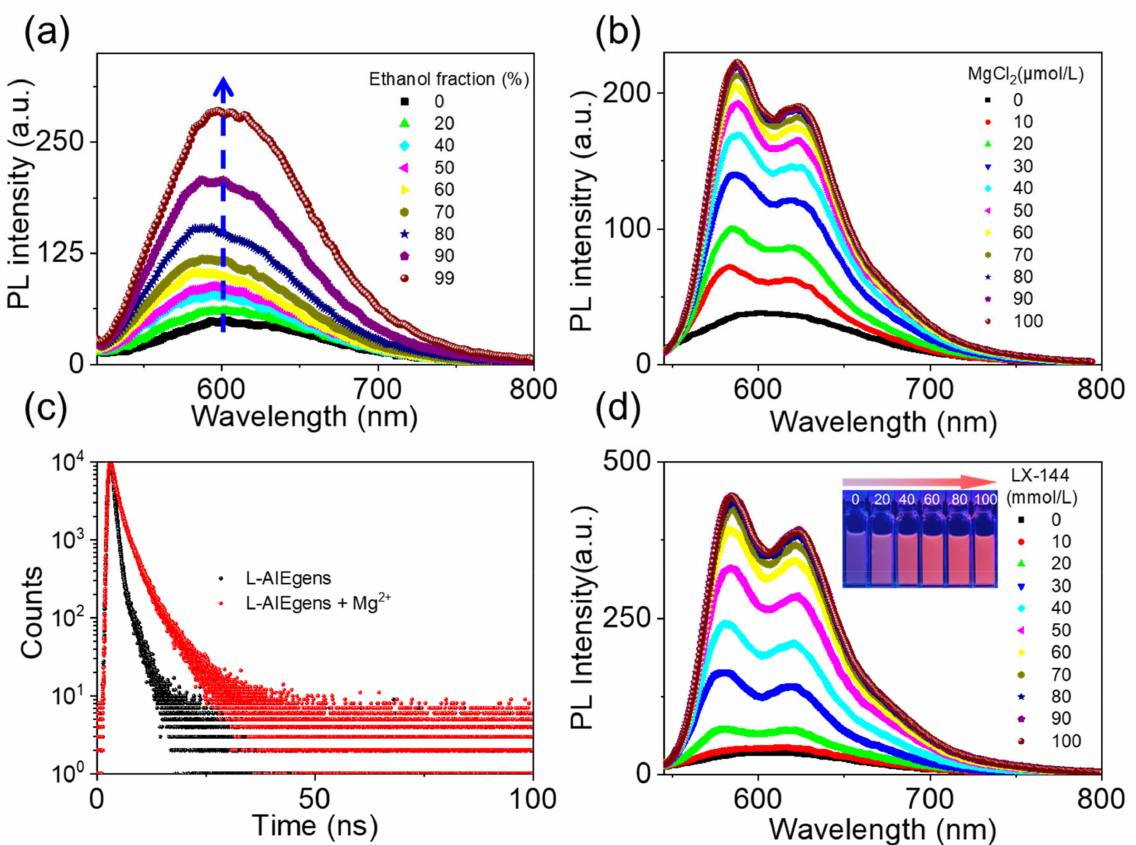
Figure 2. ( a ) Changes in the fluorescence of L-AIEgen in aqueous solution upon the addition of ethanol, with an excitation wavelength = 500 nm; ( b ) changes in the fluorescence of L-AIEgen (10 ppm) in ethanol solution upon the addition of MgCl 2 , with an excitation wavelength = 520 nm; ( c ) fluorescence lifetime of L-AIEgen in ethanol solution (10 ppm) in the presence and absence of Mg 2+ (10 ppm), with an excitation wavelength = 520 nm; ( d ) changes in the fluorescence of L-AIEgen (10 ppm) in ethanol solution upon the addition of different volumes of LX-144 (0.4 m). PL Intensity (a.u.) = photoluminescence intensity (arbitrary units), with an excitation wavelength = 520